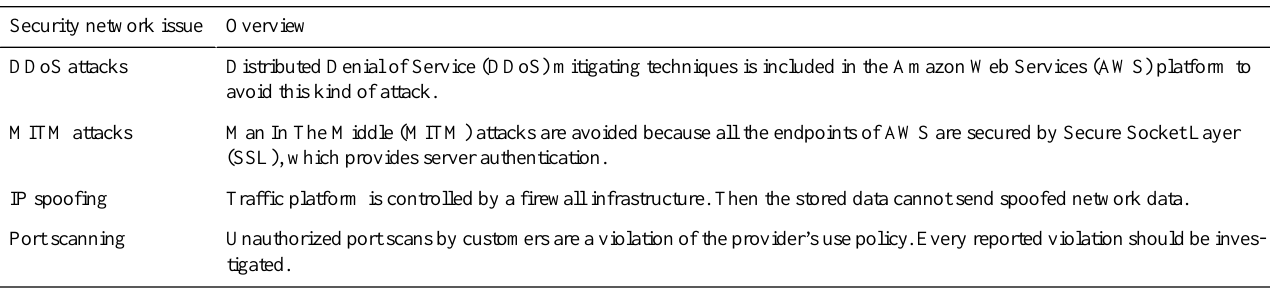
Table 7. Protection against network security issues. OverviewSecurity network